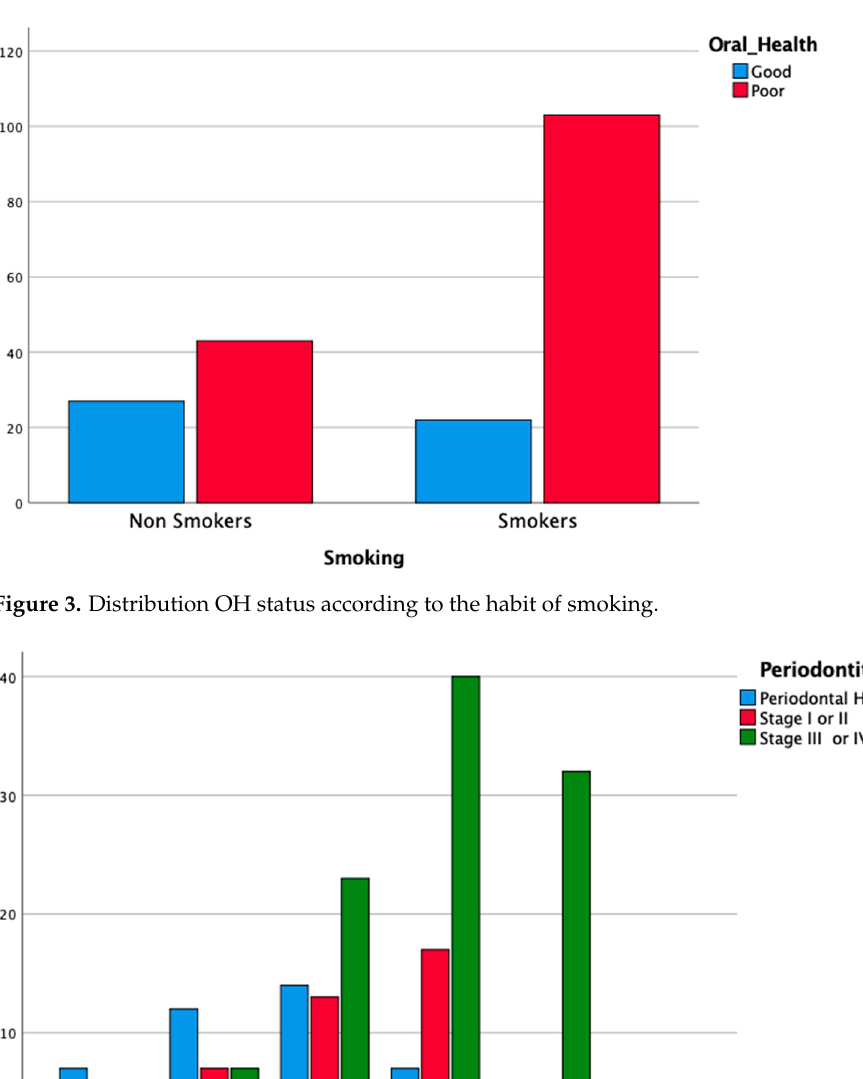
Figure 2. Distribution of DMFt < 13 according to the habit of smoking.